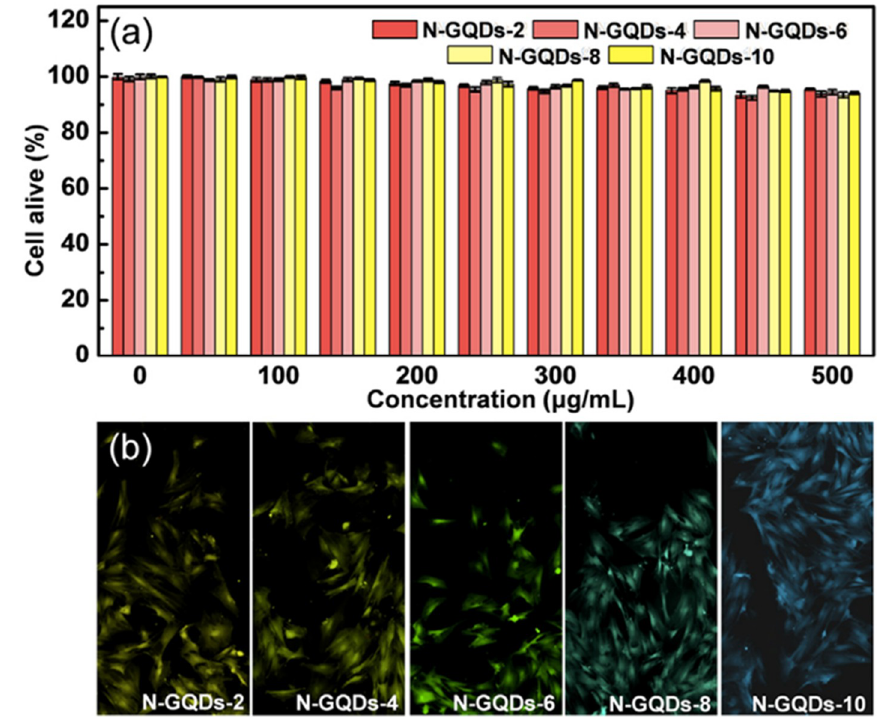
Figure 6. ( a ) Representation of concentration versus cell viability relation. Different reaction times (from 2 h to 10 h indicated as N‐GQDs‐2 to N‐GQDs‐10, respectively). ( b ) Confocal images of N‐GQDs (100 µg/mL) incubated with fibroblast cells, indicating the internalization with different colors of emission [93].